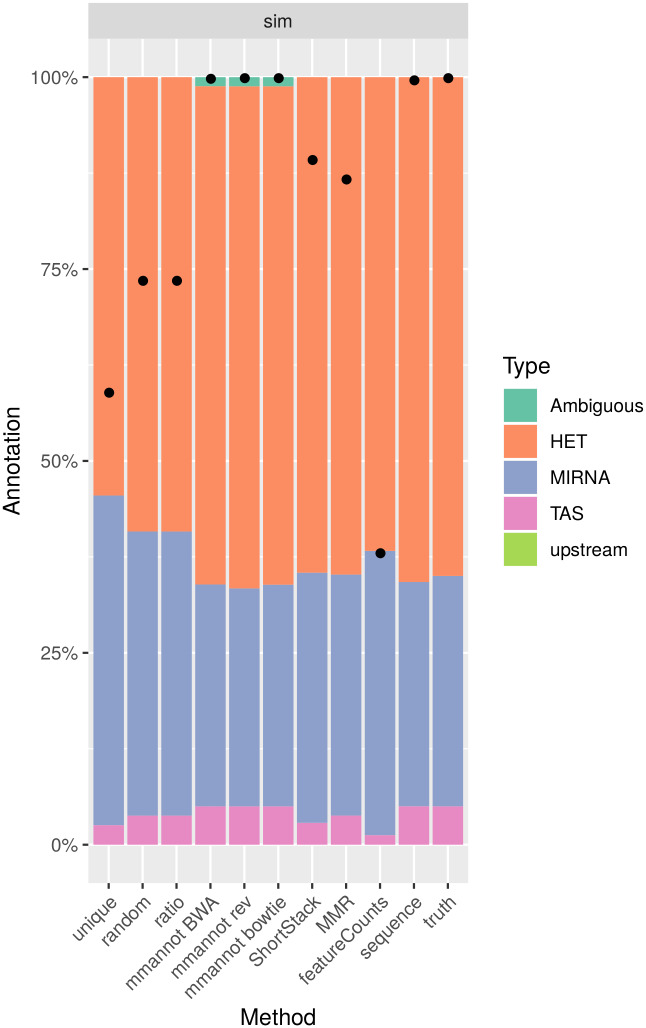
Comparison of the different strategies on the simulated data sets.The results of all but the last bars are explained in Fig 2. The “truth” bar gives the fraction of each sRNA class generated by our method.